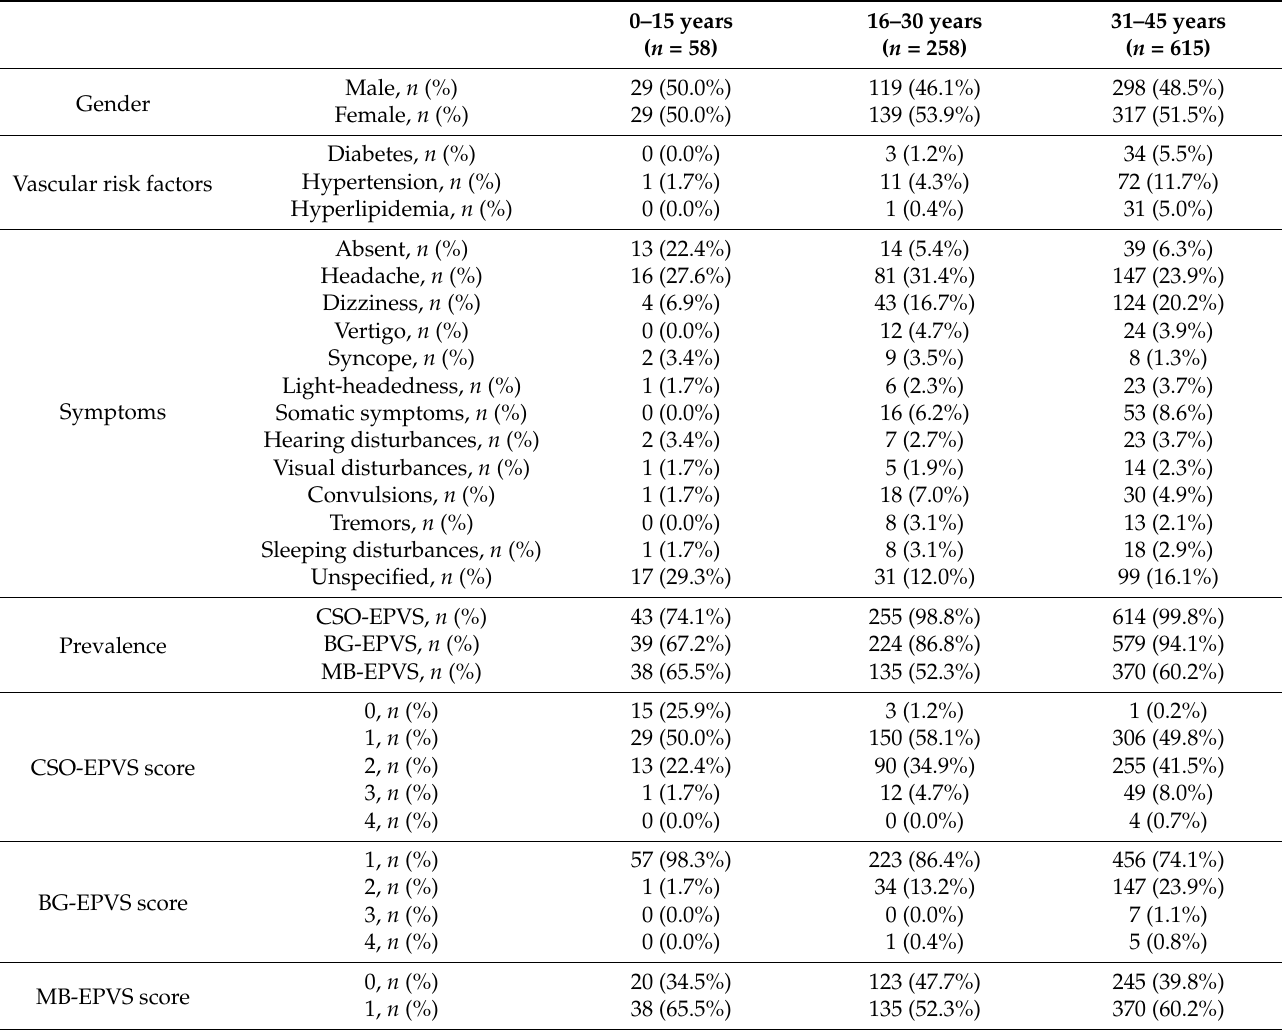
Table 1. Basic data on patient demographics, clinical symptoms, and imaging manifestations.